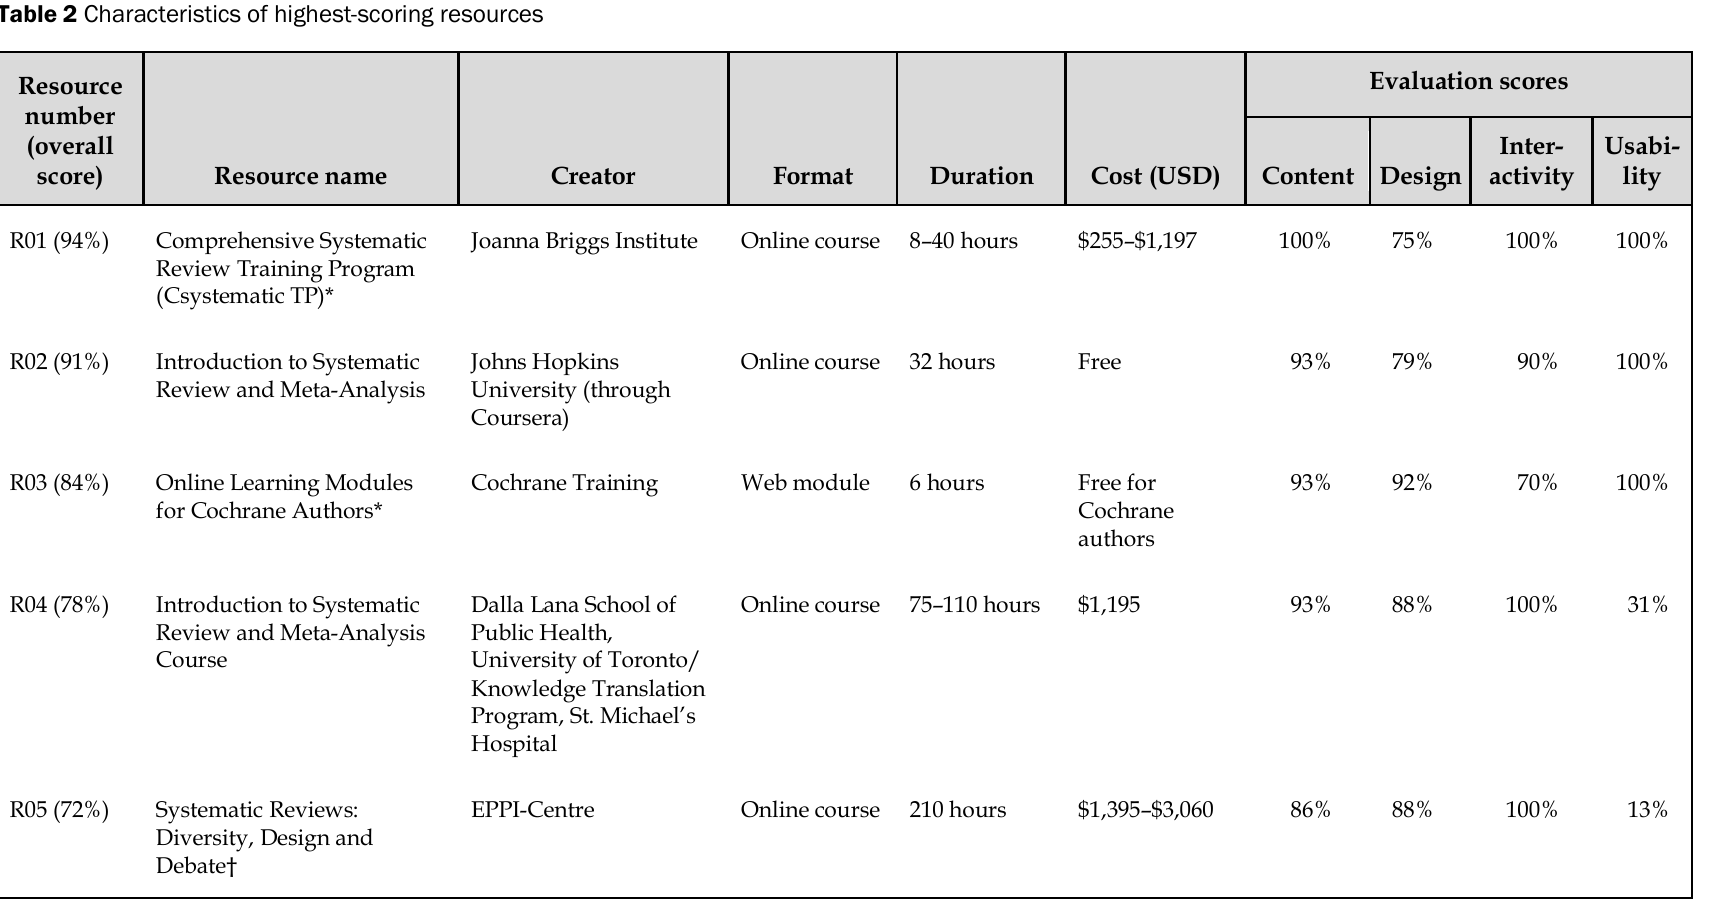
Table 2 Characteristics of highest-scoring resources